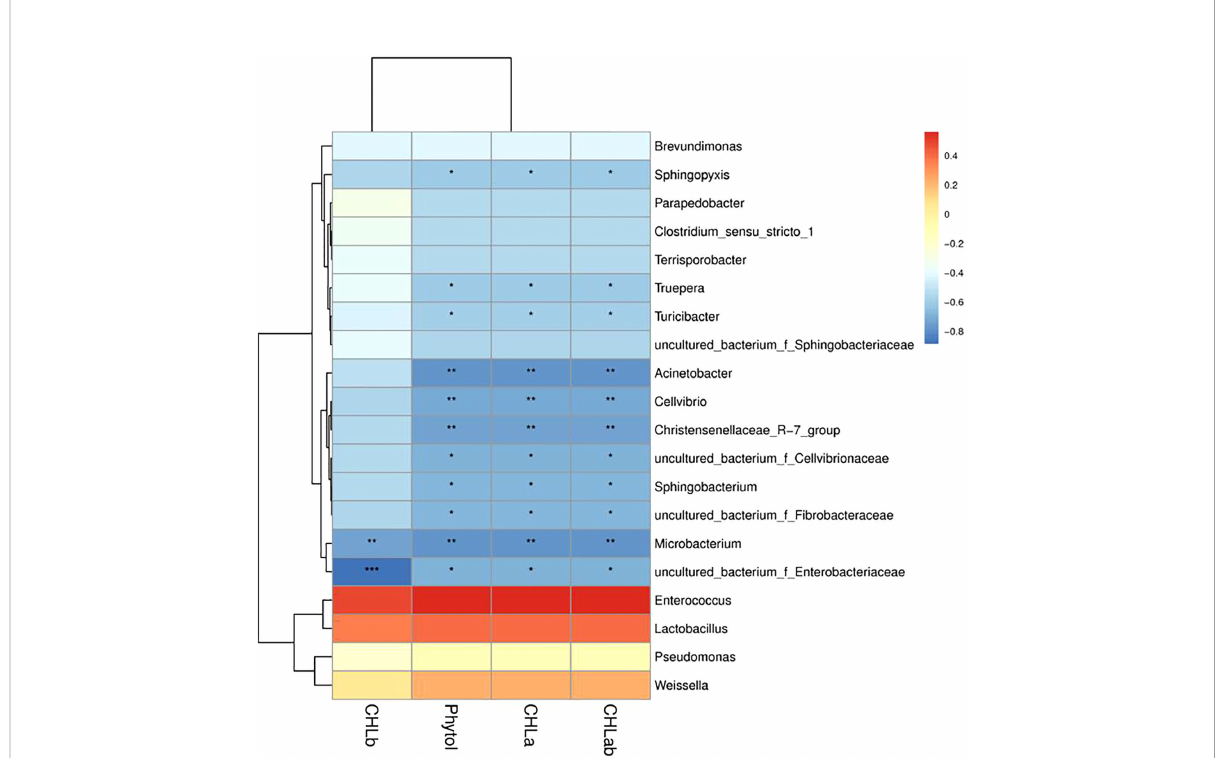
FIGURE 5 Correlations analysis between chlorophyll and phytol content and silage bacterial of Pennisetum sinese. Positive correlations are shown in red, and negative correlations are indicated in blue. Color intensity is proportional to the correlation values [r]. P -values are shown as * P < 0.05, ** P < 0.01, *** P <